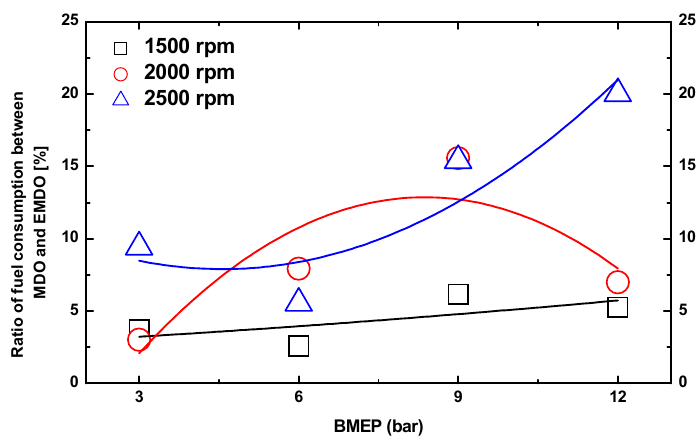
Figure 10. Fuel consumption without water content for marine diesel oil (MDO) and emulsified MDO (EMDO) fuels according to rpm.